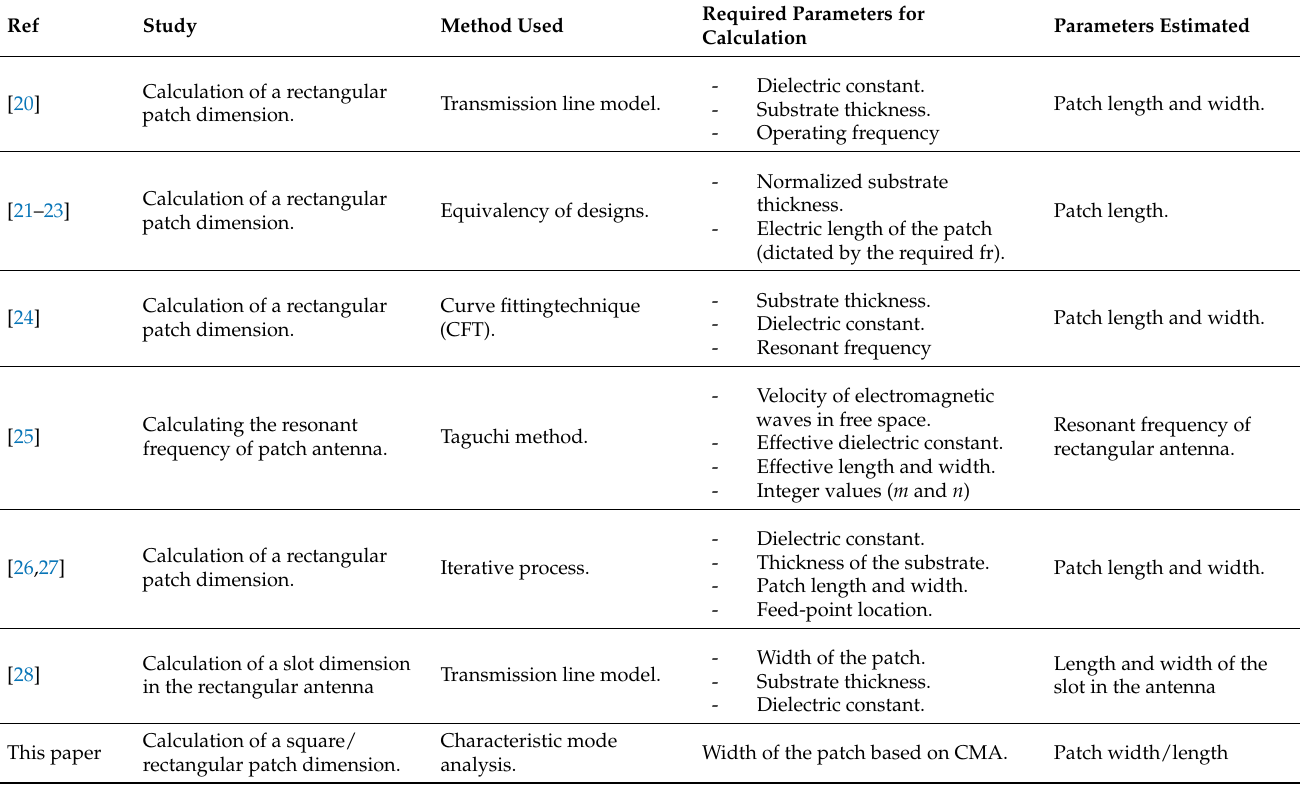
Table 8. Comparison of the proposed method with other approaches in